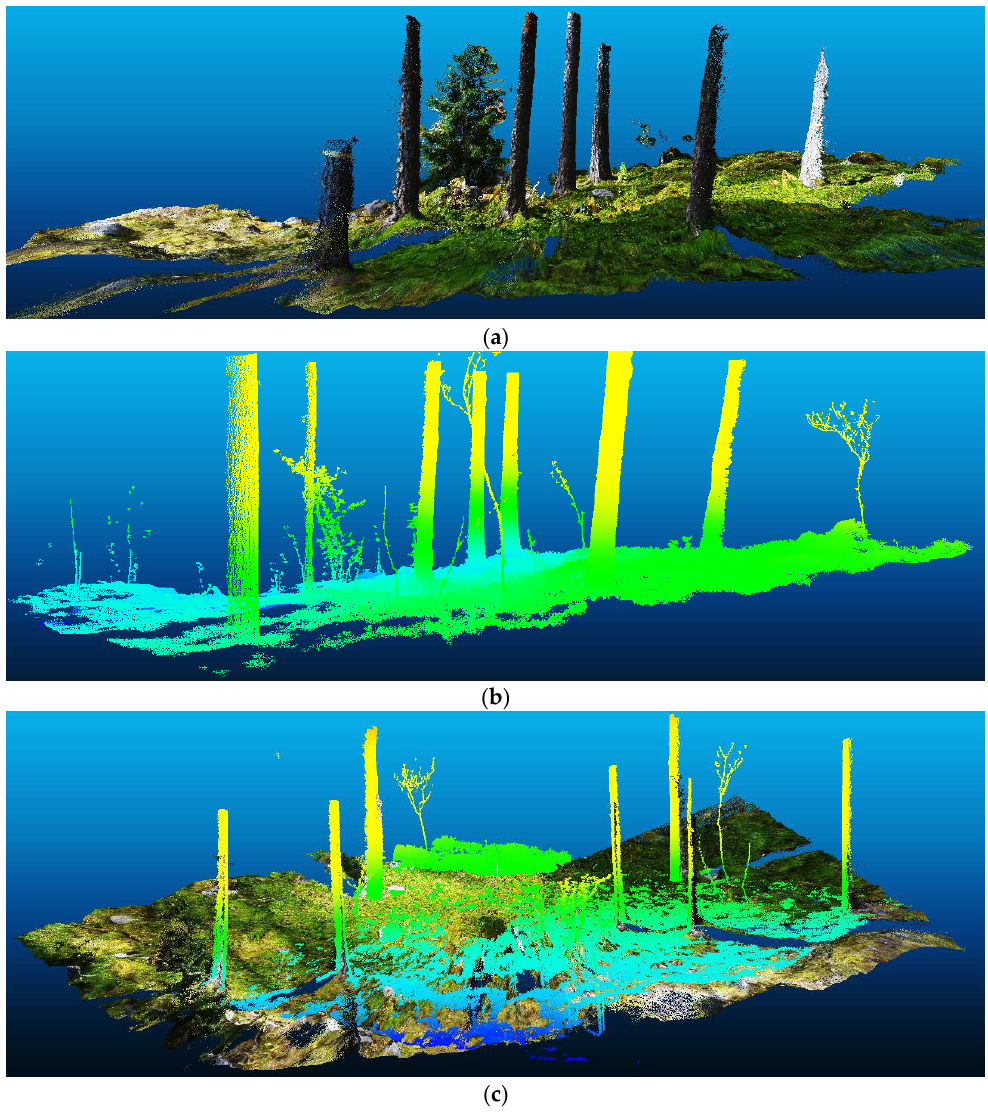
Figure 5. ( a ) Image-based point cloud; ( b ) TLS-based point cloud; ( c ) Overlap of the two point clouds.